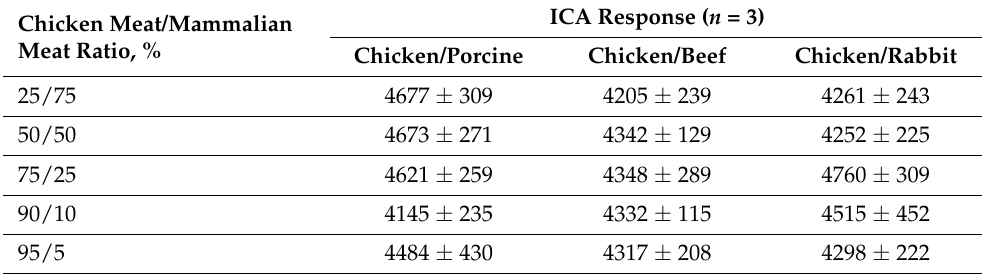
Table 2. ICA responses for meat mixtures of different compositions.